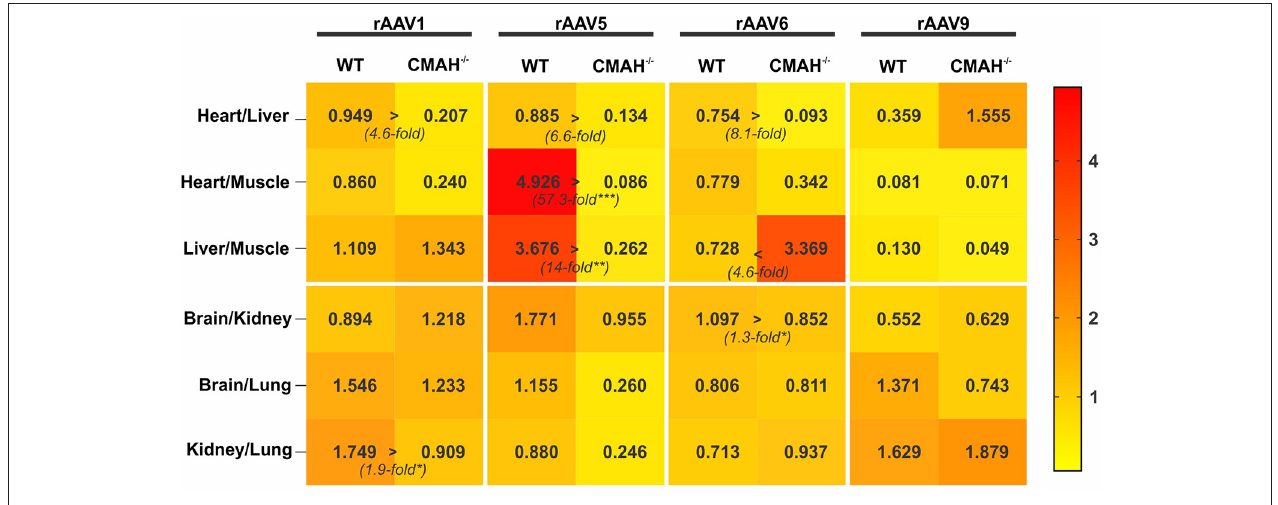
FIGURE 3 | Tropism of AAV1, AAV5, AAV6, and AAV9 in wild-type C57BL/6J (WT) vs. CMAH knockout (CMAH − / − ) mice. WT ( n = 8-10) or CMAH − / − mice ( n = 9-10) were tail vein injected with 3 × 10 11 vg of rAAV1-Luc, rAAV5-Luc, rAAV6-Luc, or rAAV9-Luc. The relative transduction of organ pairs in mice (WT or CMAH − / − ) is shown as a heatmap. The numbers in the squares correspond to the median of the ratio of relative luminescence normalized to mg of protein between the organ pairs, as indicated. * p < 0.05, ** p < 0.01, *** p < 0.001.